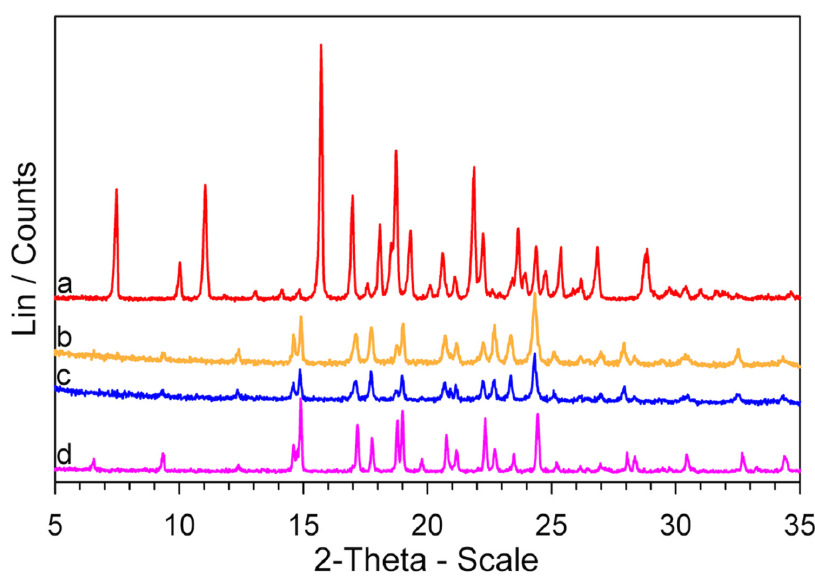
Figure 6. XRPD patterns of a GPZ production batch ( a ), (cid:1833)(cid:1842)(cid:1852) (cid:2869)(cid:2875)(cid:2868) °(cid:2887)(cid:2870)(cid:2869)(cid:2868) (cid:2923)(cid:2919)(cid:2924) ( b ), (cid:1833)(cid:1842)(cid:1852) (cid:2869)(cid:2876)(cid:2873) °(cid:2887)(cid:2869)(cid:2870)(cid:2873) (cid:2923)(cid:2919)(cid:2924) ( c ), and GS ( d ) samples.